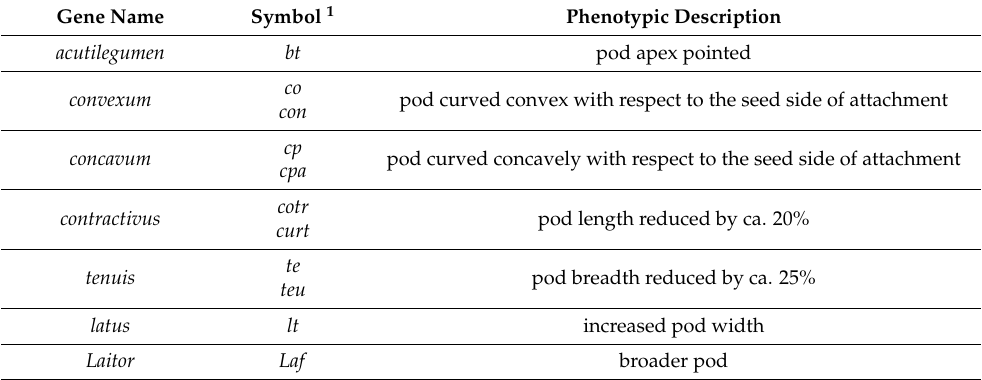
Table 1. Relevant genes relating to pod character variation in